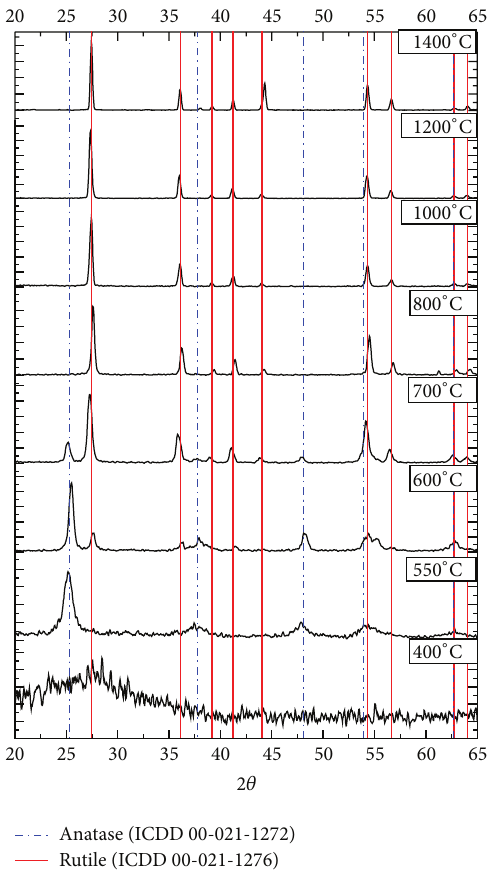
Figure 2: Graph representing the XRD of solution B TiO 2 nanofi- bers.